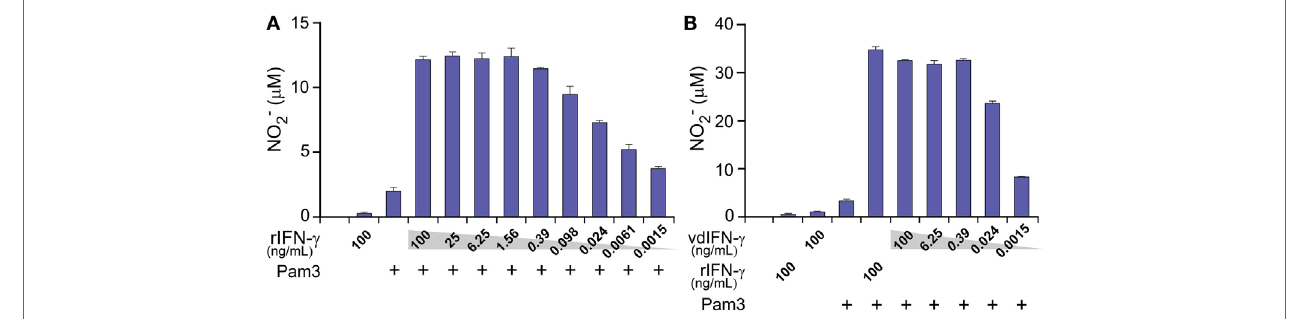
FigUre 10 | The production of nitric oxide (NO) by macrophages at 24 h after activation was determined by analyzing NO 2 − levels in the cell culture medium. Mitomycin C-treated bone marrow-derived macrophages (BMDMs) were cultivated for 24 h before they were activated with the TLR2/1 agonist Pam3 (100 ng/mL) in combination with either (a) rIFN- γ at various concentrations ranging from 100 to 0.0015 ng/mL in 4-fold dilutions or (B) vdIFN- γ at concentratios ranging from 100 to 0.0015 ng/mL in 16-fold dilutions. Non-stimulated BMDMs and BMDMs that were stimulated with Pam3, rIFN- γ , or vdIFN- γ were used as the negative controls. Nitrite ( )NO 2 − levels were measured in the macrophage culture medium at 24 h post-stimulation using the Griess test. Experiments were performed in triplicates and were repeated two times with similar results. The bars represent the mean values of triplicates ± SEM from one representative